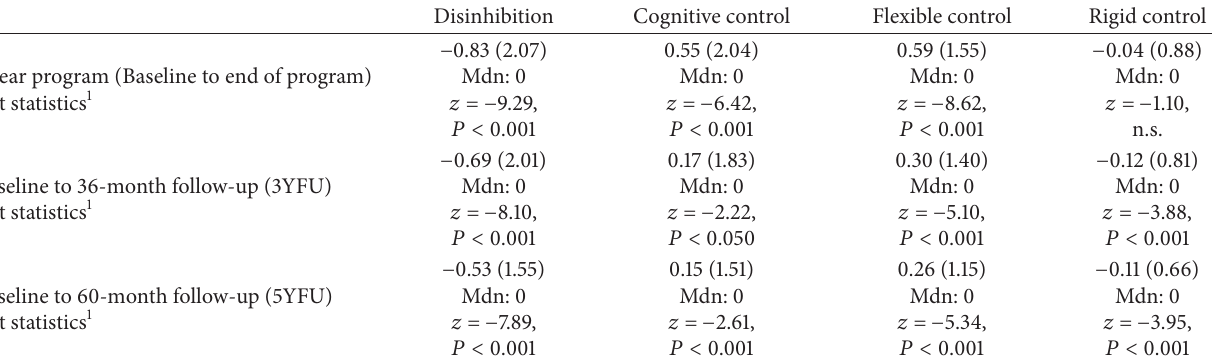
Table 4: Average changes in scores of eating behaviour within 3 and 5 years after baseline (mean difference (SD); 𝑁 = 604 ; baseline observation carried forward).